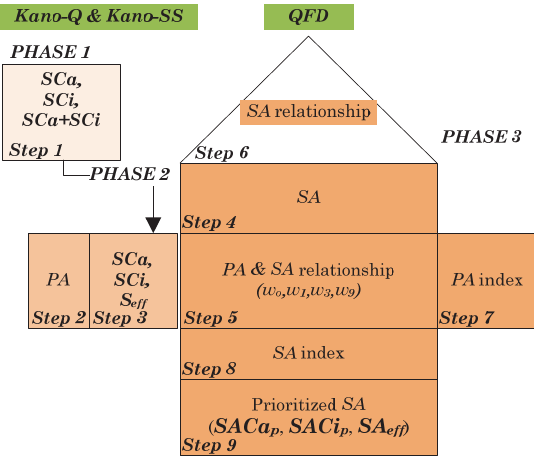
Fig. 2. The flow of information from Kano-QFD Step 1 to Step